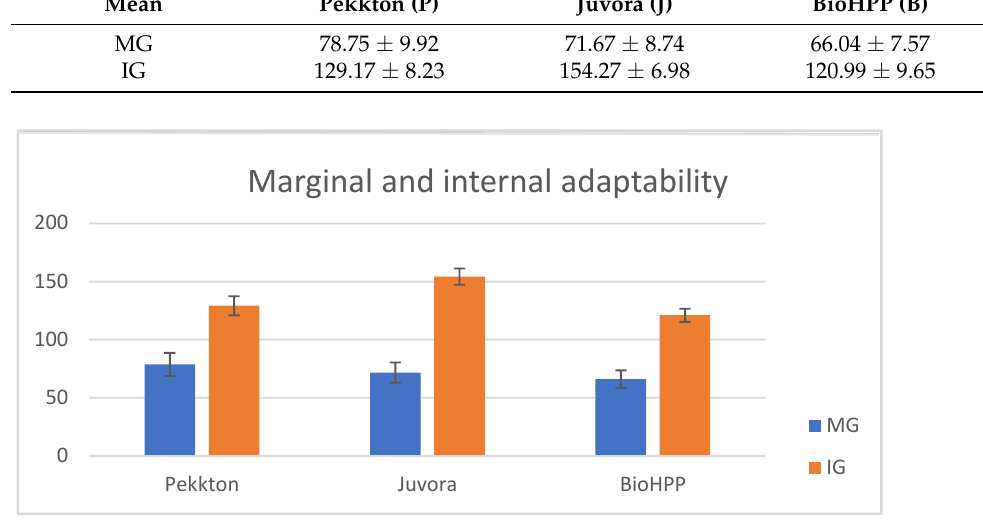
Figure 5. The marginal and internal discrepancy mean values for all three materials.